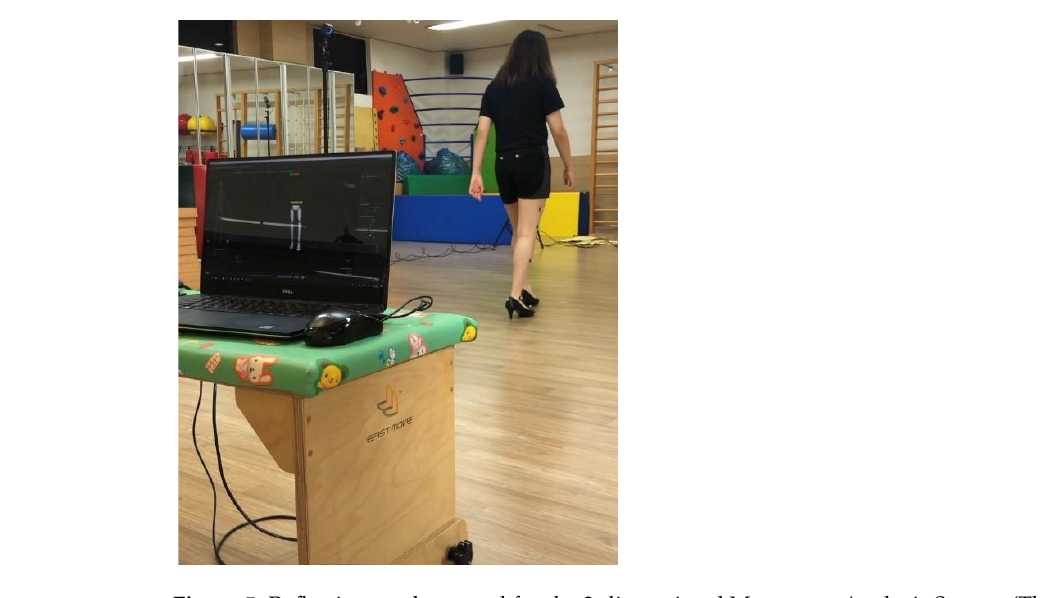
Figure 5. Reflection markers used for the 3-dimensional Movement Analysis System (The Optitrack 3D Motion Capture System).